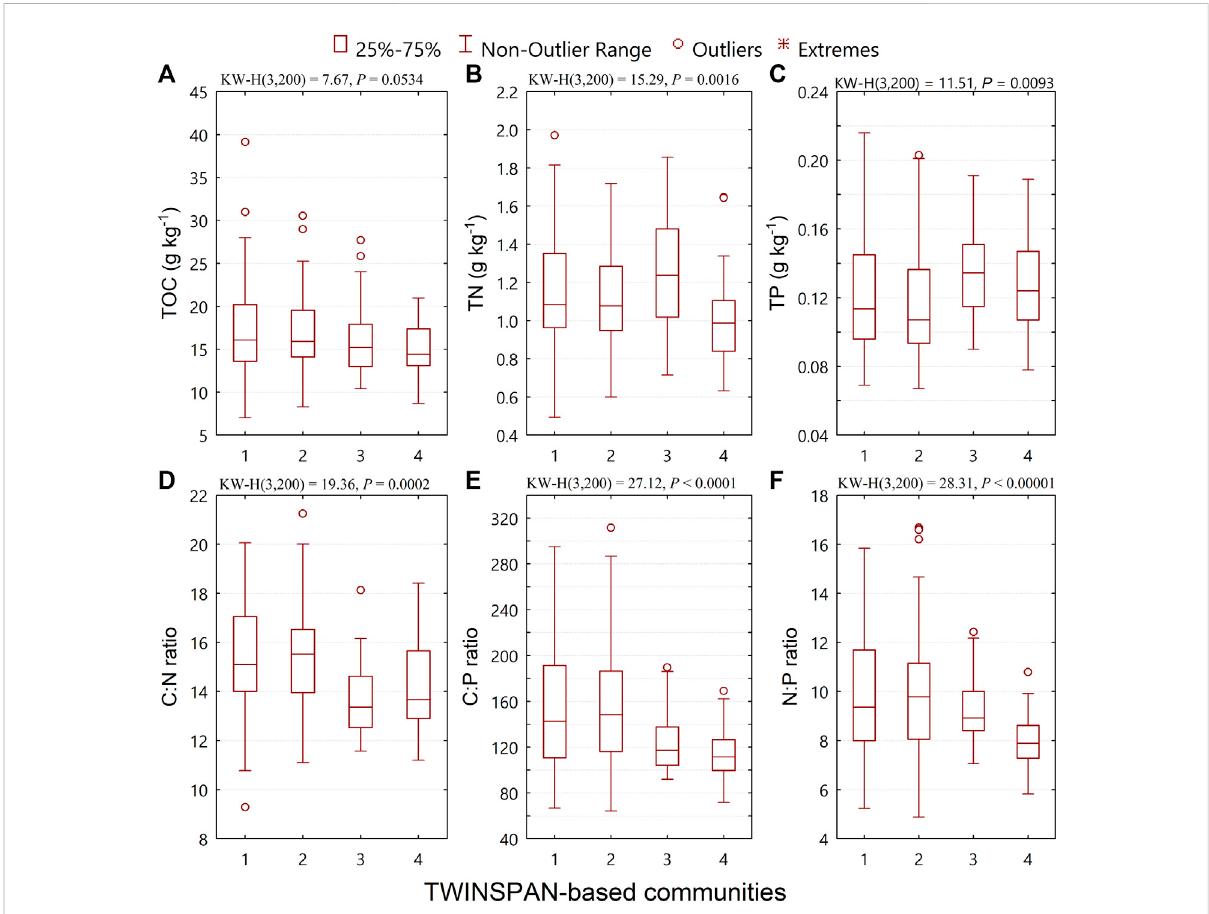
FIGURE 1 Changesinsoiltotalorganiccarbon(TOC),totalnitrogen(TN),totalphosphorus(TP),andC:N:PstoichiometricratiosacrossTWINSPAN-based